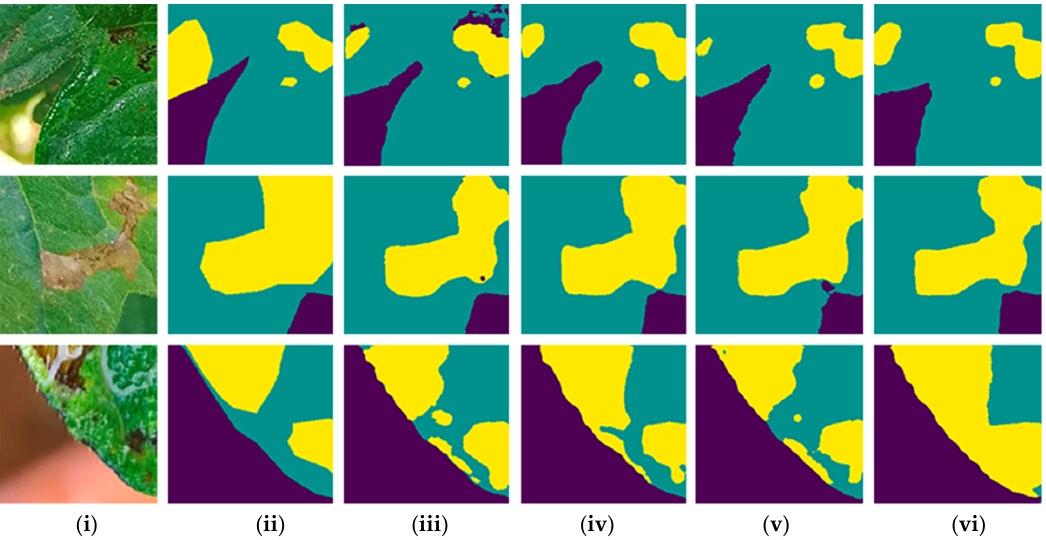
Figure 3. Visual comparison of the results of the multiclass semantic segmentation from the FPN model performed on the testing database. ( i ) Original image, ( ii ) reference annotation, ( iii ) VGG16, ( iv ) DenseNet121, ( v ) Inceptionv3, ( vi ) ResNet34. The background class is purple, the tomato leaf